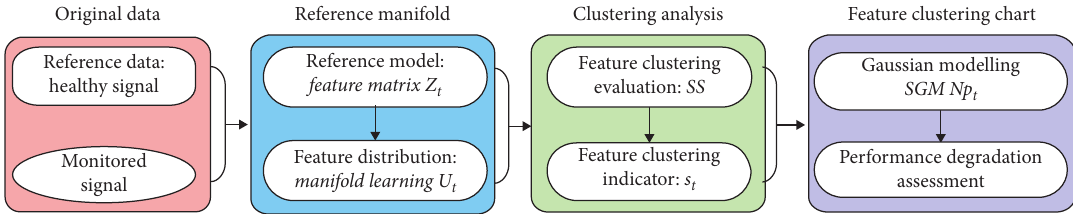
Figure 1: The framework of the feature clustering system for rolling bearing performance degradation assessment.